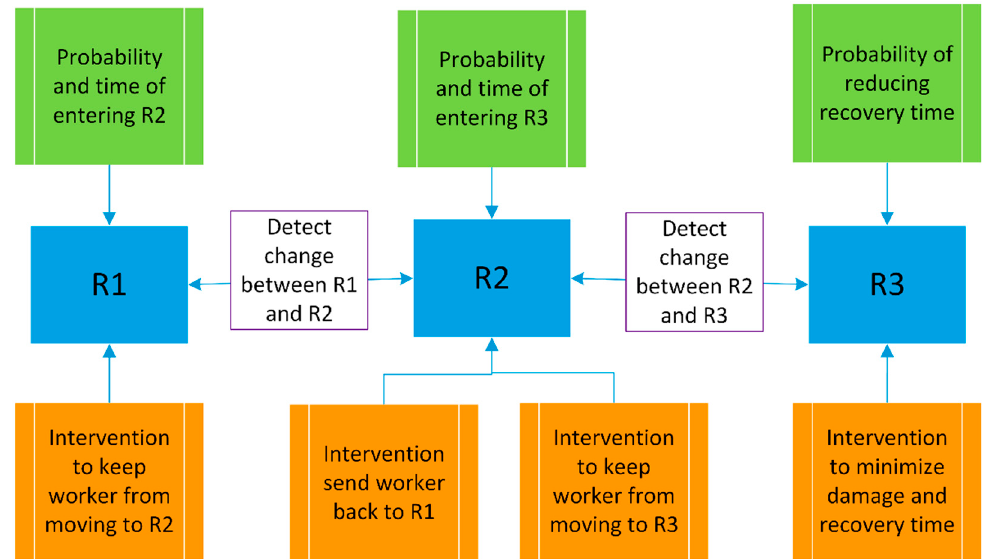
Figure 4. The Risk Evolution, Detection, Evaluation, and Control of Accidents (REDECA) framework for AI OSH. Blue boxes are the different states a worker can find themselves in. R1 is the state when a worker has minimal to no risk of exposure. R2 indicates exposure to hazard and an increased risk of injury. R3 indicates a harmful work-related event occurred. Green boxes indicate technologies that can predict the probability of transitioning into the next states. White boxes are technologies that can detect transitions between the states. Orange boxes indicate the intervention strategies to keep the worker safe or reduce the impact of a work-related event.